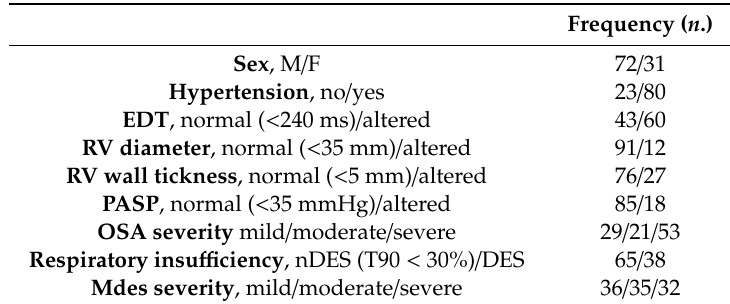
Table 2. Stratification of patient characteristics, nCRP, and ETT evaluations based on reference values or classification